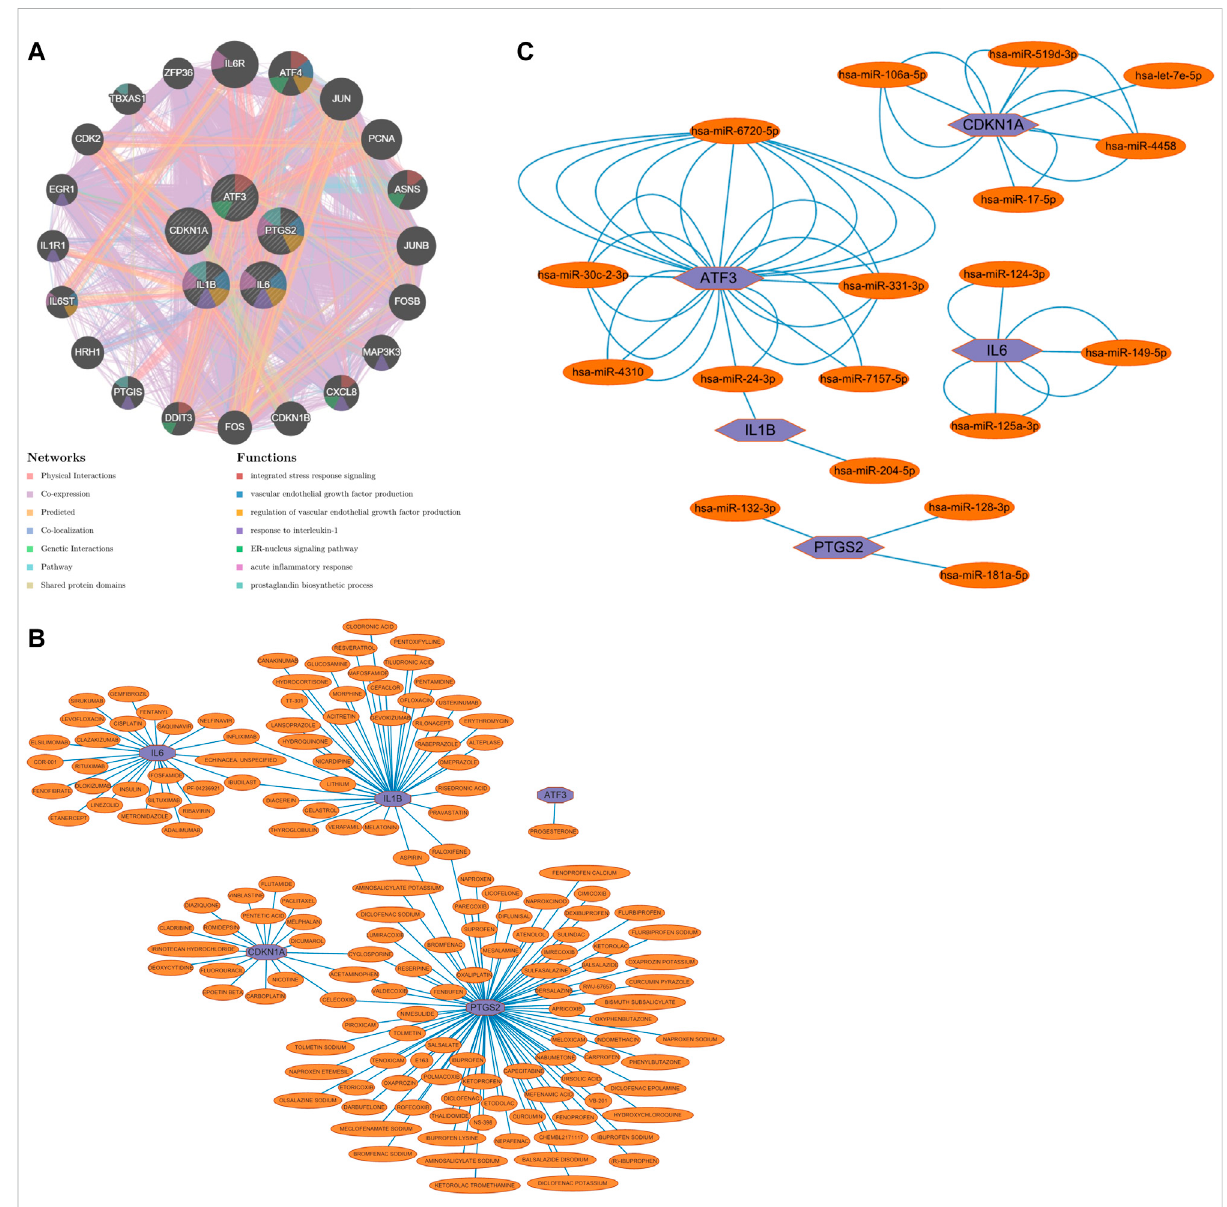
FIGURE 8 (A) Prediction of gene interactions on Hub Gene, (B) Prediction of drug-gene interactions on Hub Gene, (C) The miRNA expression prediction on Hub